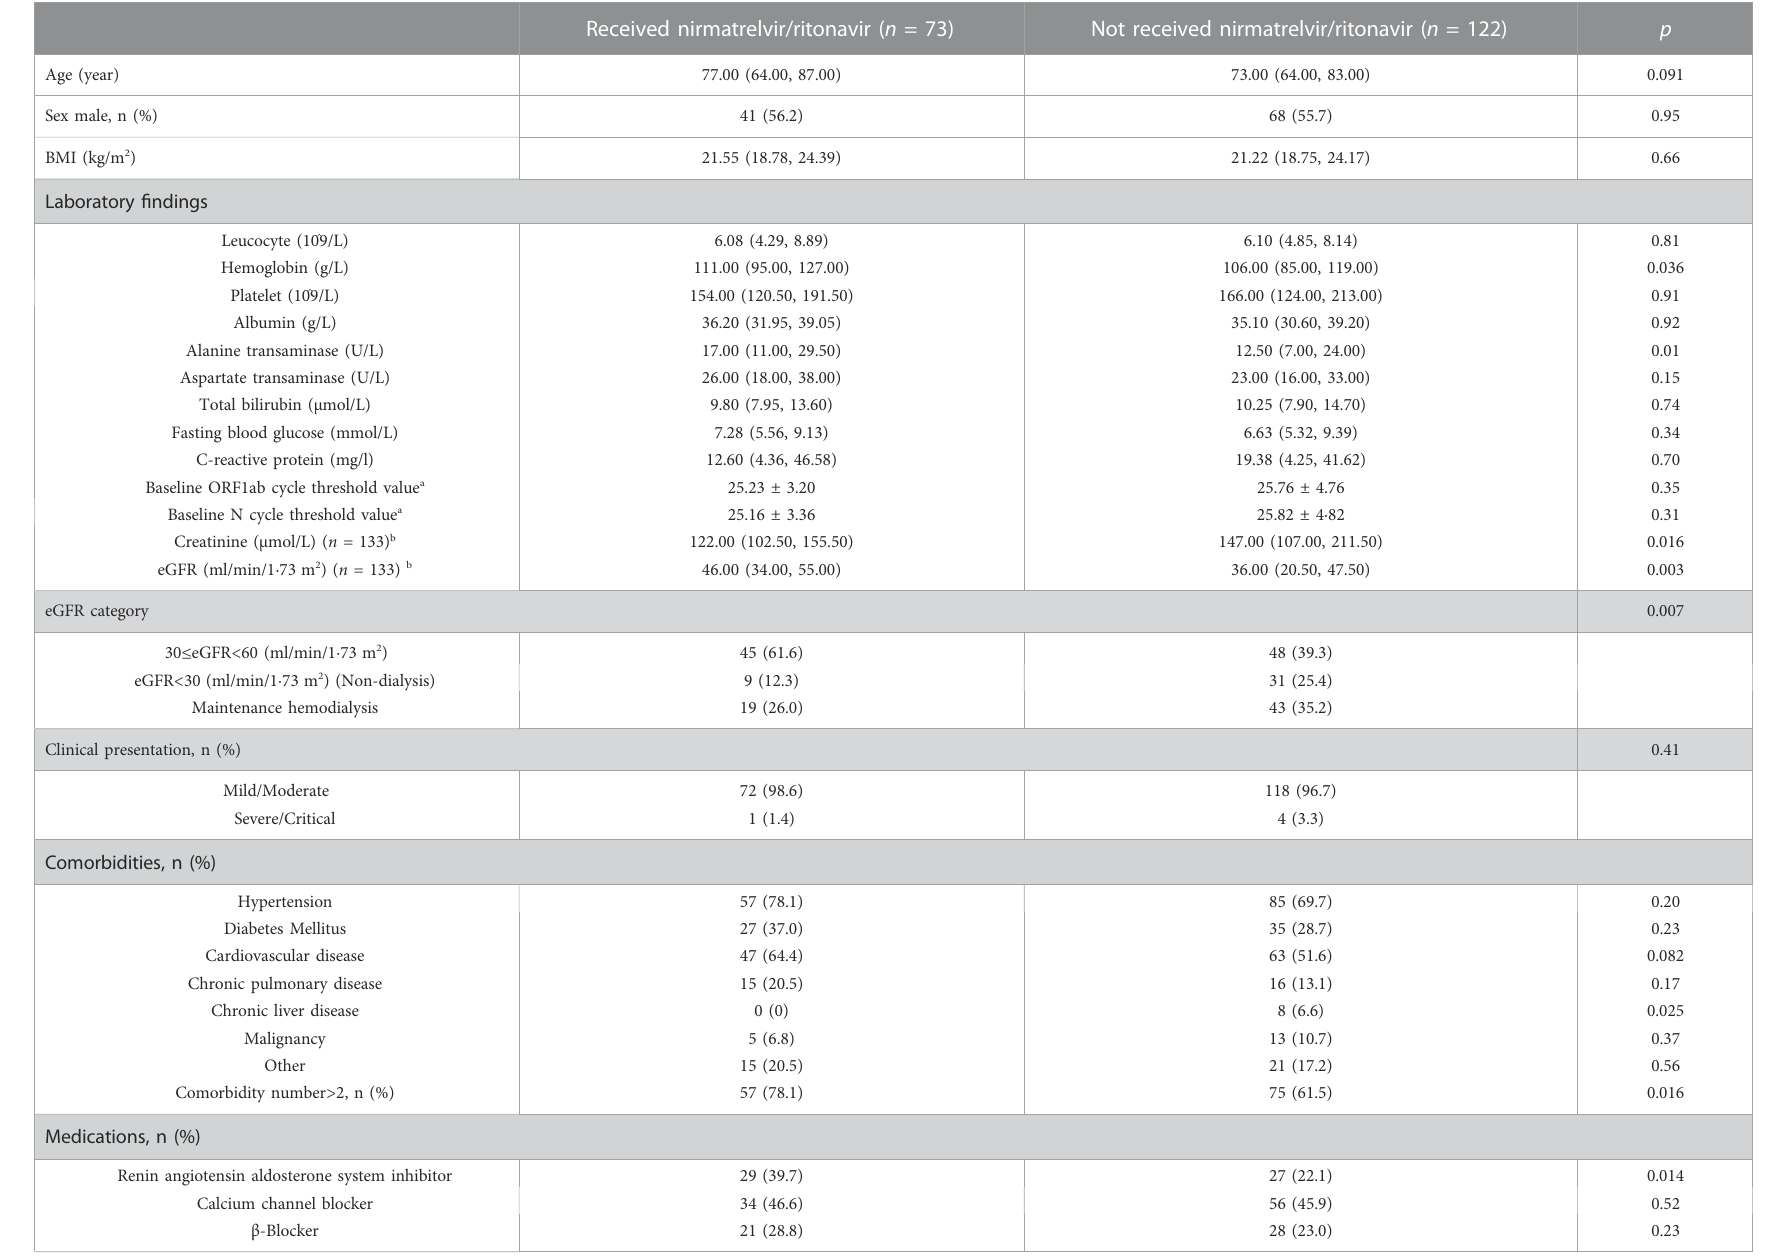
TABLE 2 Characteristics of patients with SARS-CoV-2 infection and impaired kidney function with or without Nirmatrelvir/ritonavir